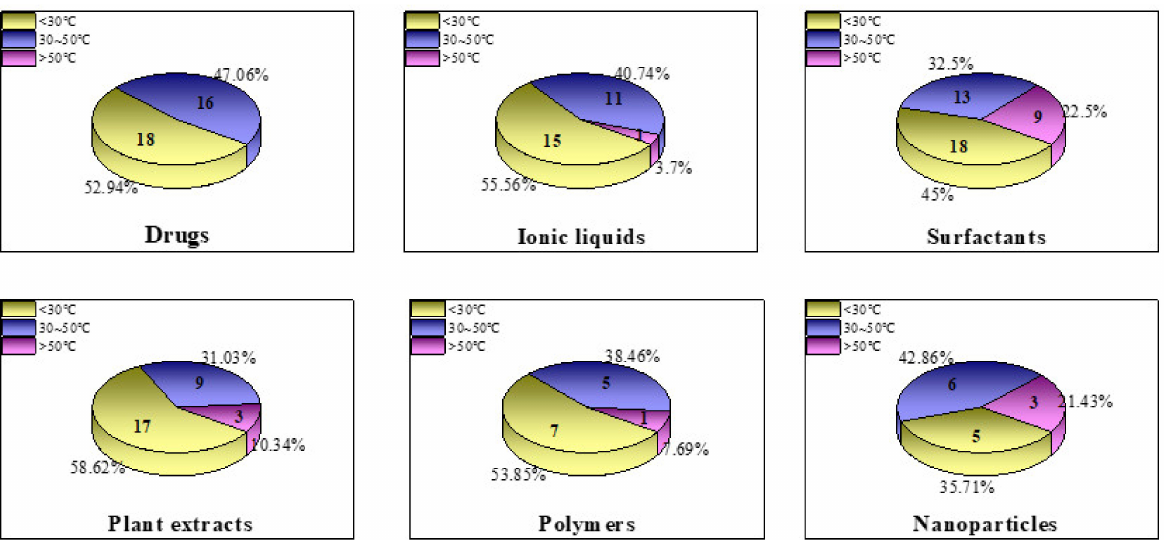
Figure 19. The number and the percentage of each type of inhibitor at the indicated range of temper- atures that achieved the maximum inhibition efficiency. The source of the data is in Supplementary Tables